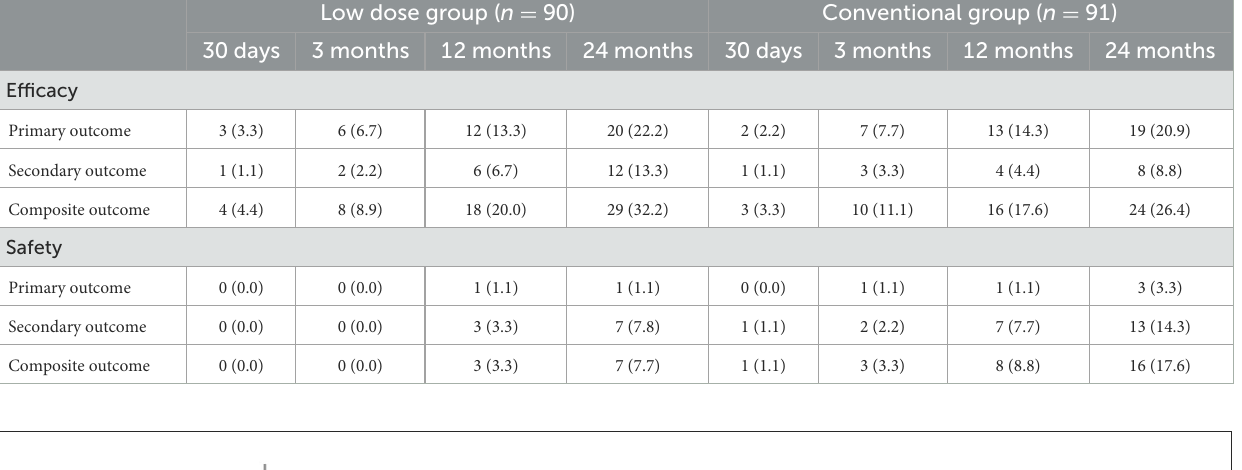
TABLE 3 Efficacy and safety outcomes in the low dose group and conventional group ( n , %).